Question: According to this chart, does the measure grow or shrink?
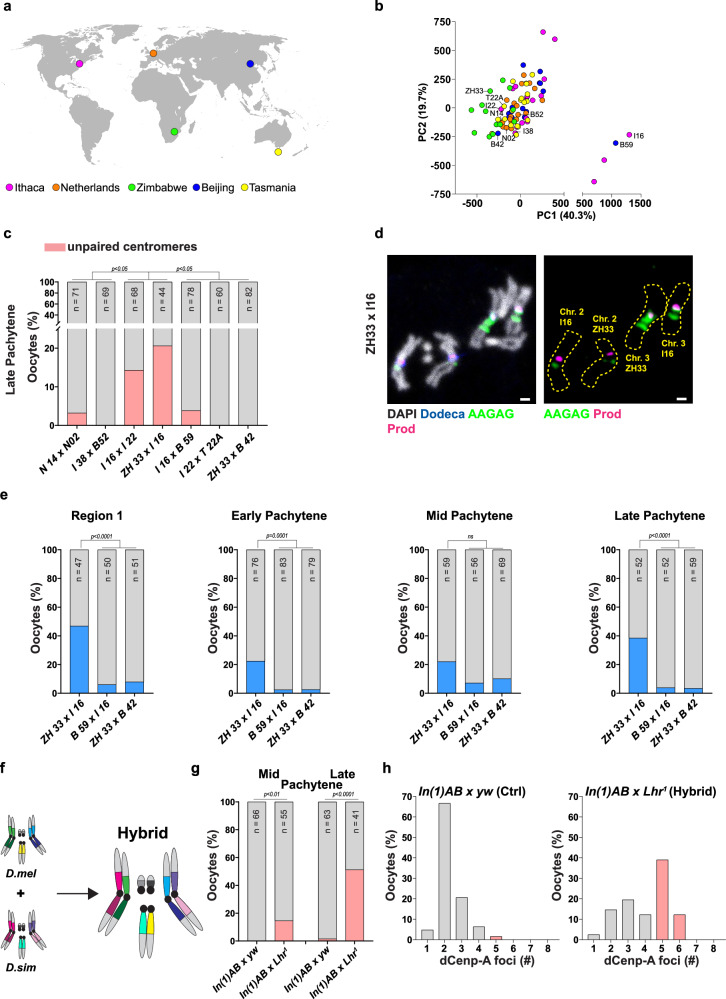
Answer: increasing